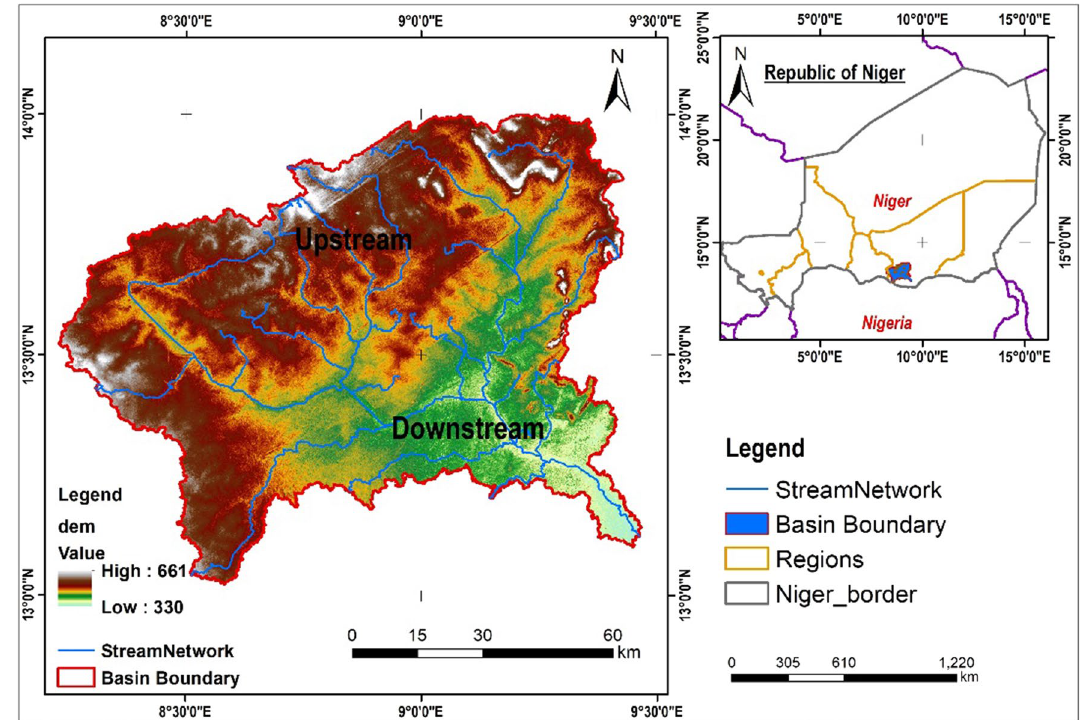
Fig. 1 Location of the study